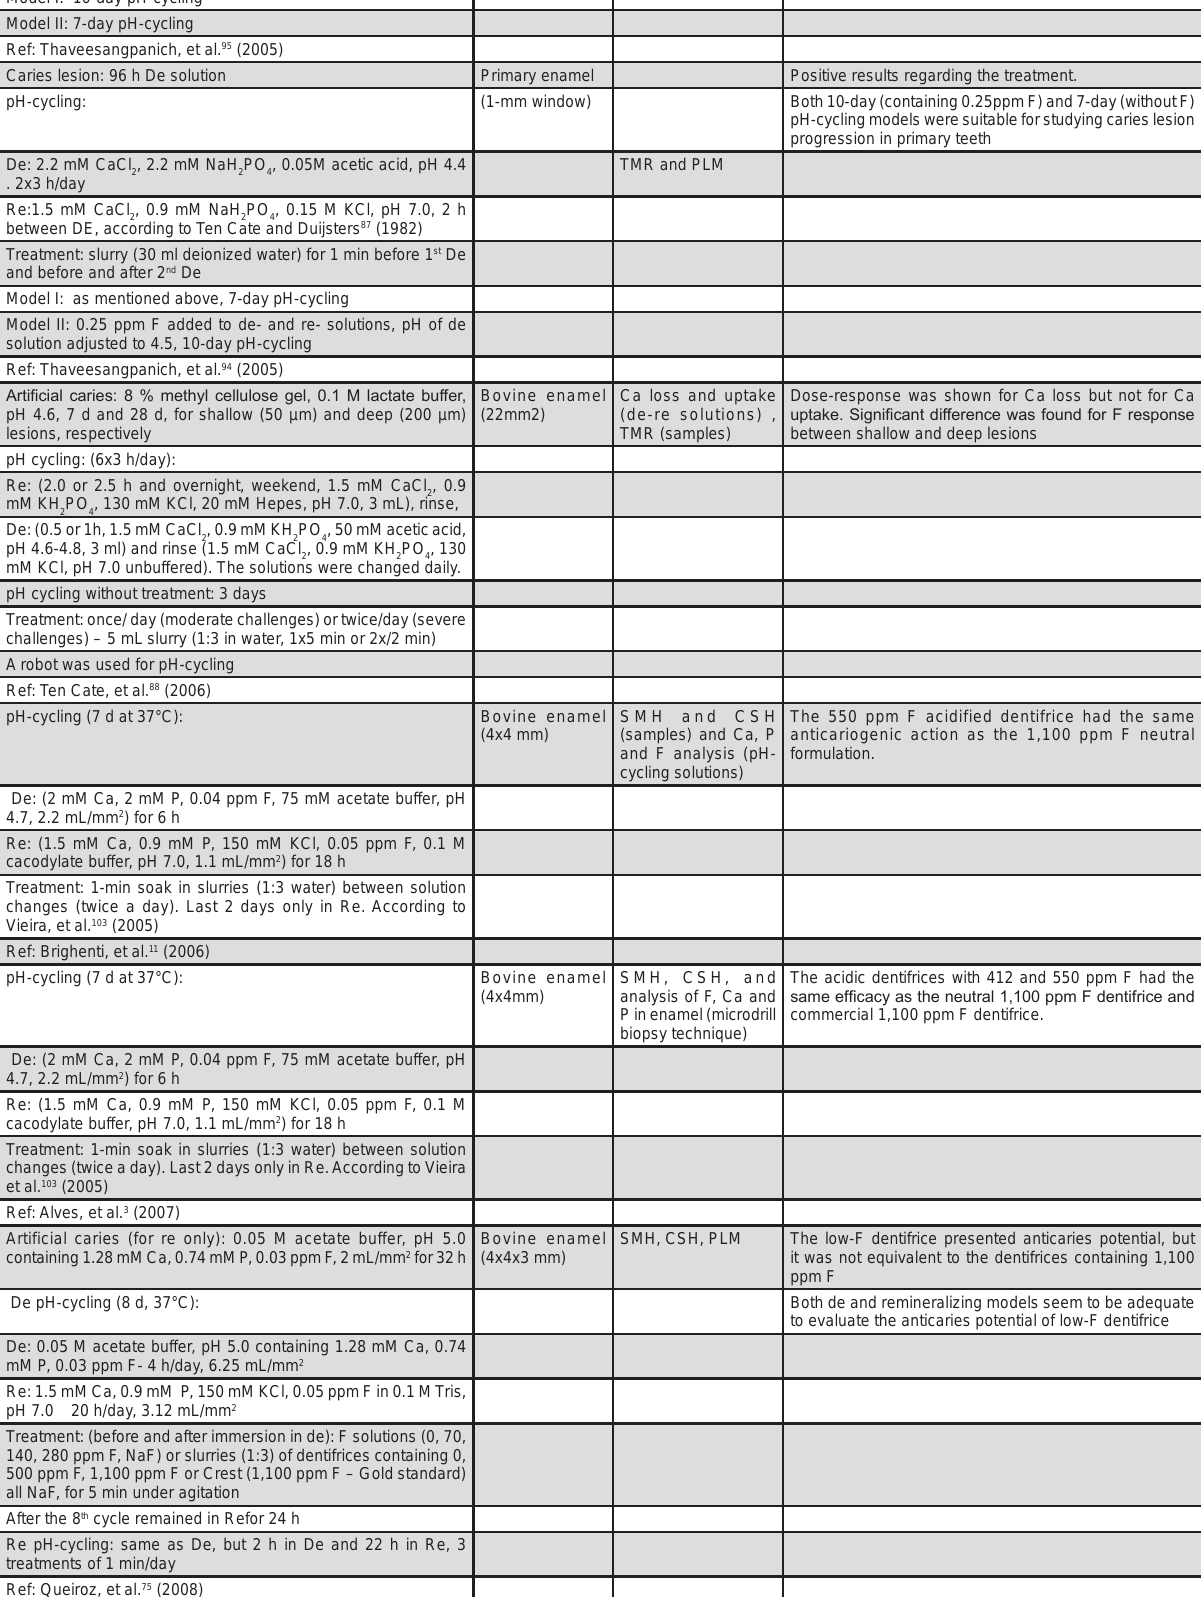
Figure 3- pH-cycling studies evaluating the dose-response or pH-response of fluoridated dentifrices for caries